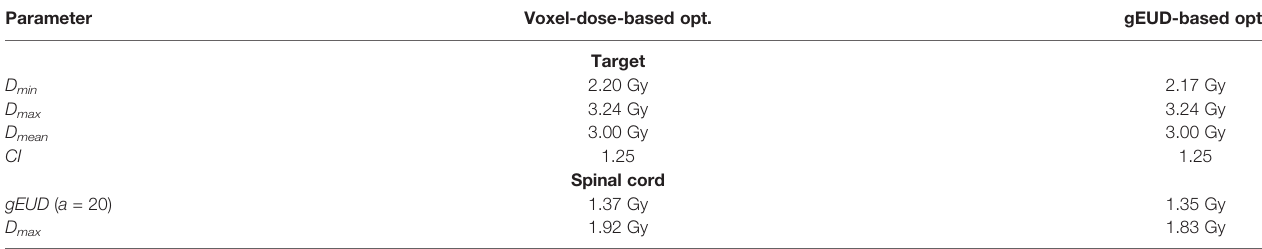
TABLE 2 | gEUD and other dosimetric indexes for the VOIs of plan 135. Parameter Voxel-dose-based opt.